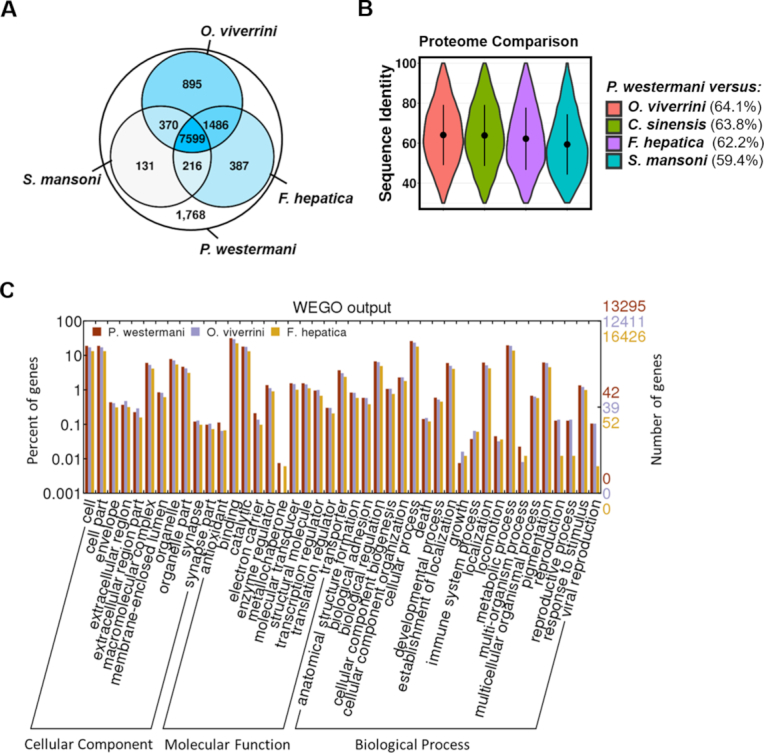
Conservation of the P. westermani proteome across four related trematode species. Paragonimus westermani proteins were mapped to the genome sequences of O. viverrini, C. sinensis, F. hepatica, and S. mansoni using Exonerate. (A)Paragonimus westermani centered Venn diagram of 12,852 predicted proteins. The four included trematode species shared a core set of 7,599 proteins. (B) Sequence identity of P. westermani proteins and orthologues inferred in genomes of related trematodes. Average sequence identity is given in brackets. (C) Distribution of identified functional GO categories across three trematode species. GO annotations were assigned by InterProScan and visualized using WEGO.